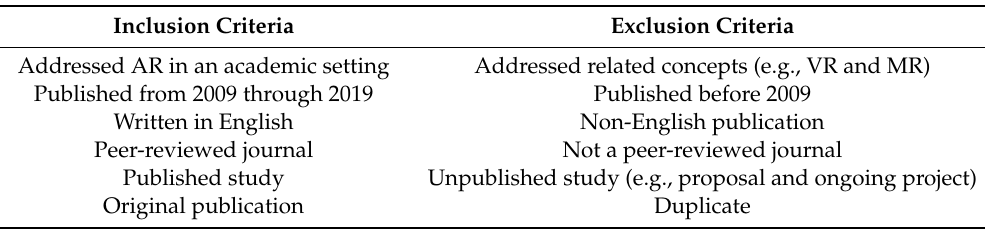
Table 1. Inclusion and exclusion